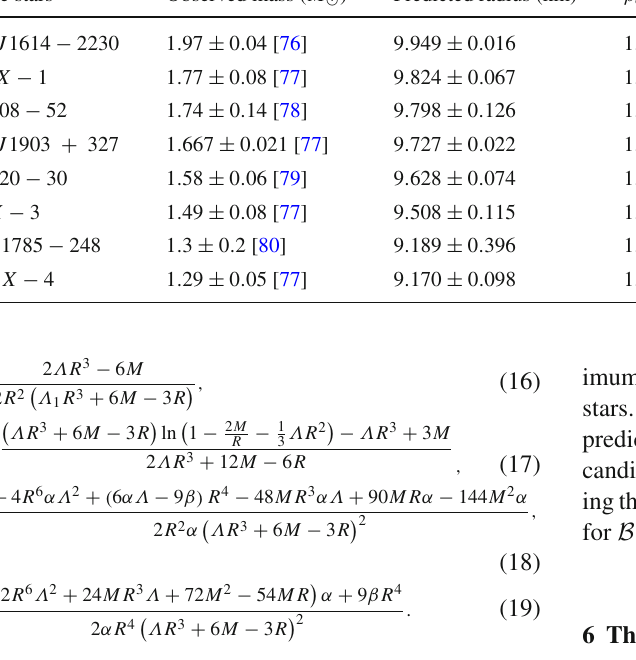
Table 1 Numerical values of physical parameters for the different star candidates for Λ = 0 . 005 and B = 60MeV / fm 3 Strange stars Observed mass ( M (cid:4) ) Predicted radius (km) ρ c ( g / cm 3 ) p c ( dyne / cm 2 ) Surface redshift 2 M